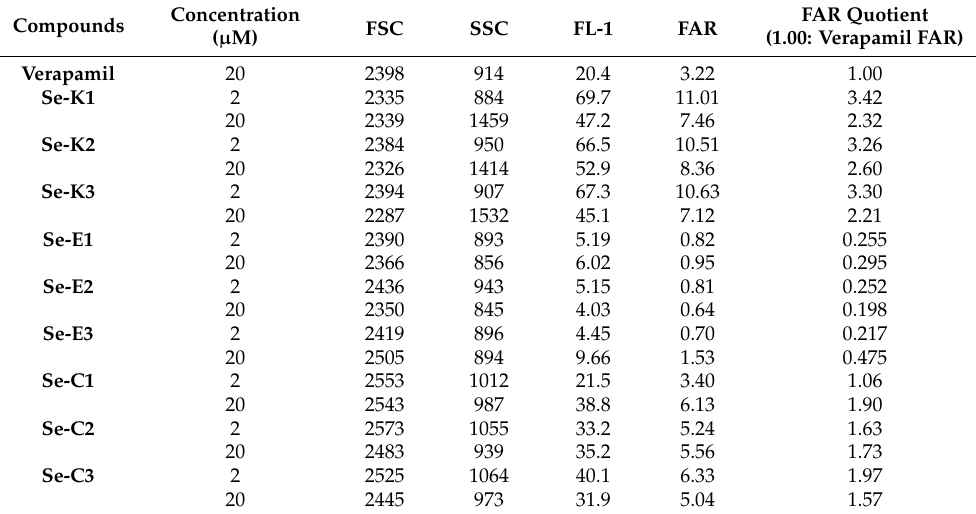
Table 2. ABCB1 modulating activity of symmetrical selenoesters in Colo 320 cells.